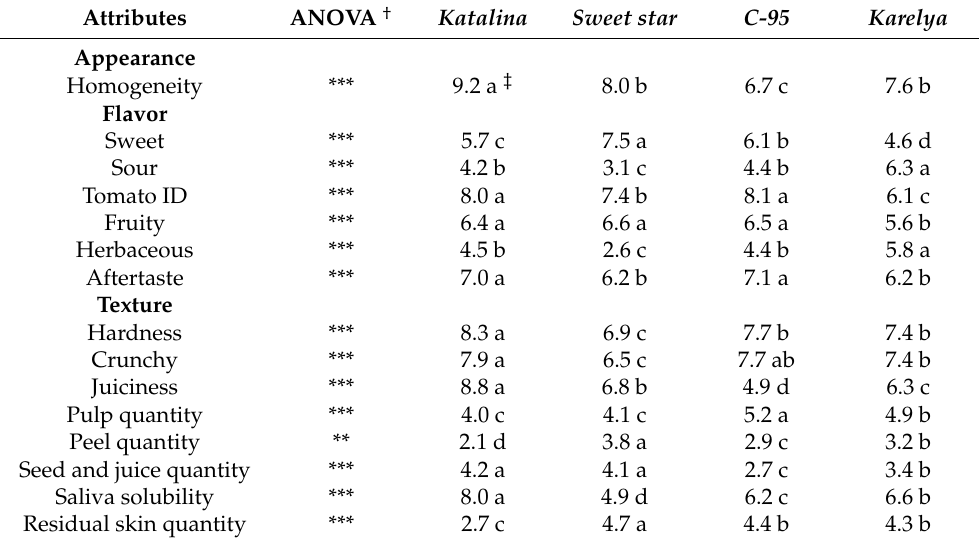
Table 5. Descriptive sensory analysis in round cherry tomatoes as affected by cultivar.